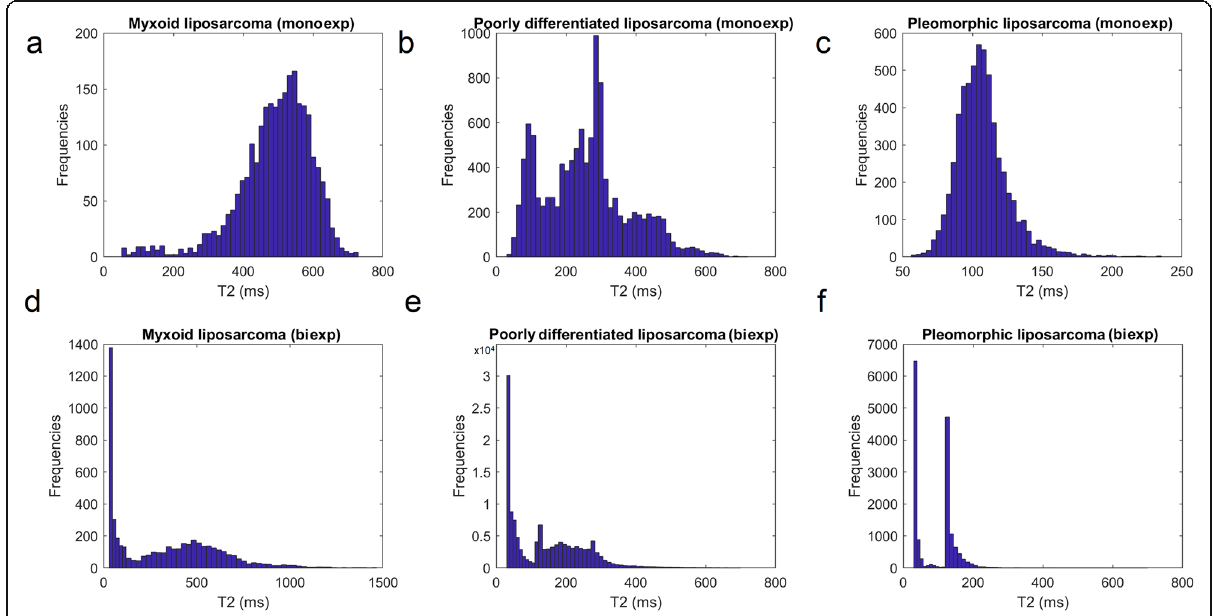
Fig. 6 Derived spectra from mixed monoexponential and biexponential tissue samples for myxoid liposarcoma monoexponential spectrum ( a ), poorly differentiated liposarcoma monoexponential spectrum ( b ), pleomorphic liposarcoma monoexponential spectrum ( c ), myxoid liposarcoma biexponential spectrum ( d ), poorly differentiated liposarcoma biexponential spectrum ( e ), and pleomorphic liposarcoma biexponential spectrum ( f ). exp